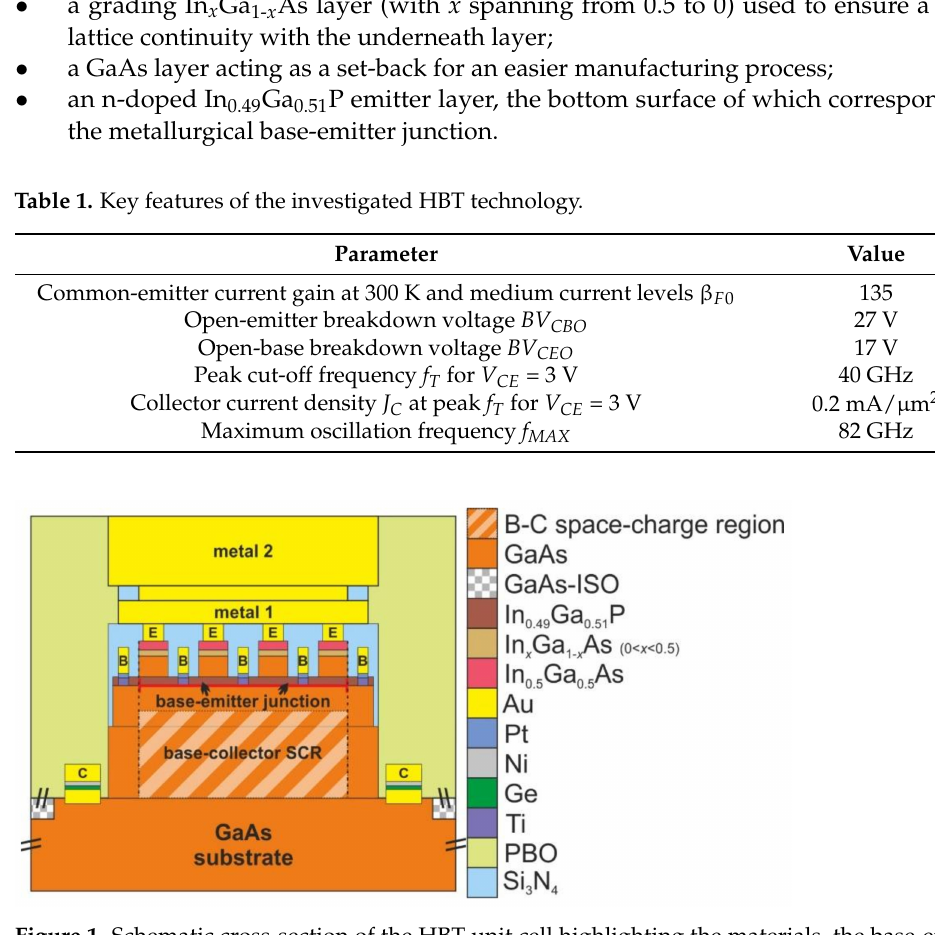
Figure 1. Schematic cross-section of the HBT unit cell highlighting the materials, the base-emitter junction, and the base-collector space-charge region